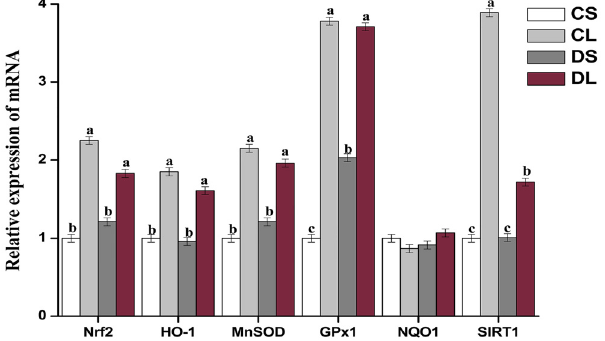
Fig 7. Effects of DMG-Na on mRNA expression of antioxidant genes in LPS injected mice liver. Values are mean ± SEMs (n = 10). Mean of a variable without a common letter differ, P < 0.05. Nuclear factor erythroid 2-related factor 2 ( Nrf2 ); Heme oxygenase 1 ( HO-1 ); Manganese superoxide dismutase ( MnSOD ); Glutathione peroxidase 1 ( Gpx1 ); NAD(P)H quinone oxidoreductase 1 ( NQO1 ); Sirtuin 1 ( Sirt1 ). CS, gastric intubation in mice with 0 mg DMG-Na/0.3 ml sterile saline solution for 28 days and intraperitoneal injection with 100 μ g/kg body weight of sterile saline solution at 29 day; CL, gastric intubation in mice with 0 mg DMG-Na/0.3 ml sterile saline solution for 28 days and intraperitoneal injection with 100 μ g/kg body weight of LPS at 29 day; DS, gastric intubation in mice with 12 mg DMG-Na/0.3 ml sterile saline solution for 28 days and intraperitoneal injection with 100 μ g/kg body weight of sterile saline solution at 29 day; DL, gastric intubation in mice with 12 mg DMG-Na/0.3 ml sterile saline solution for 28 days and intraperitoneal injection with 100 μ g/kg body weight of LPS at 29